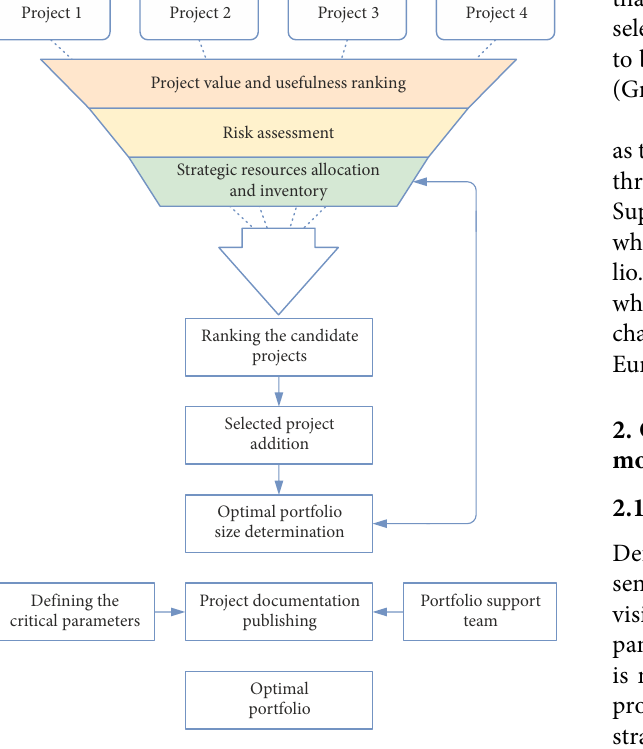
Figure 1. Portfolio project candidates selection algorithm (created by